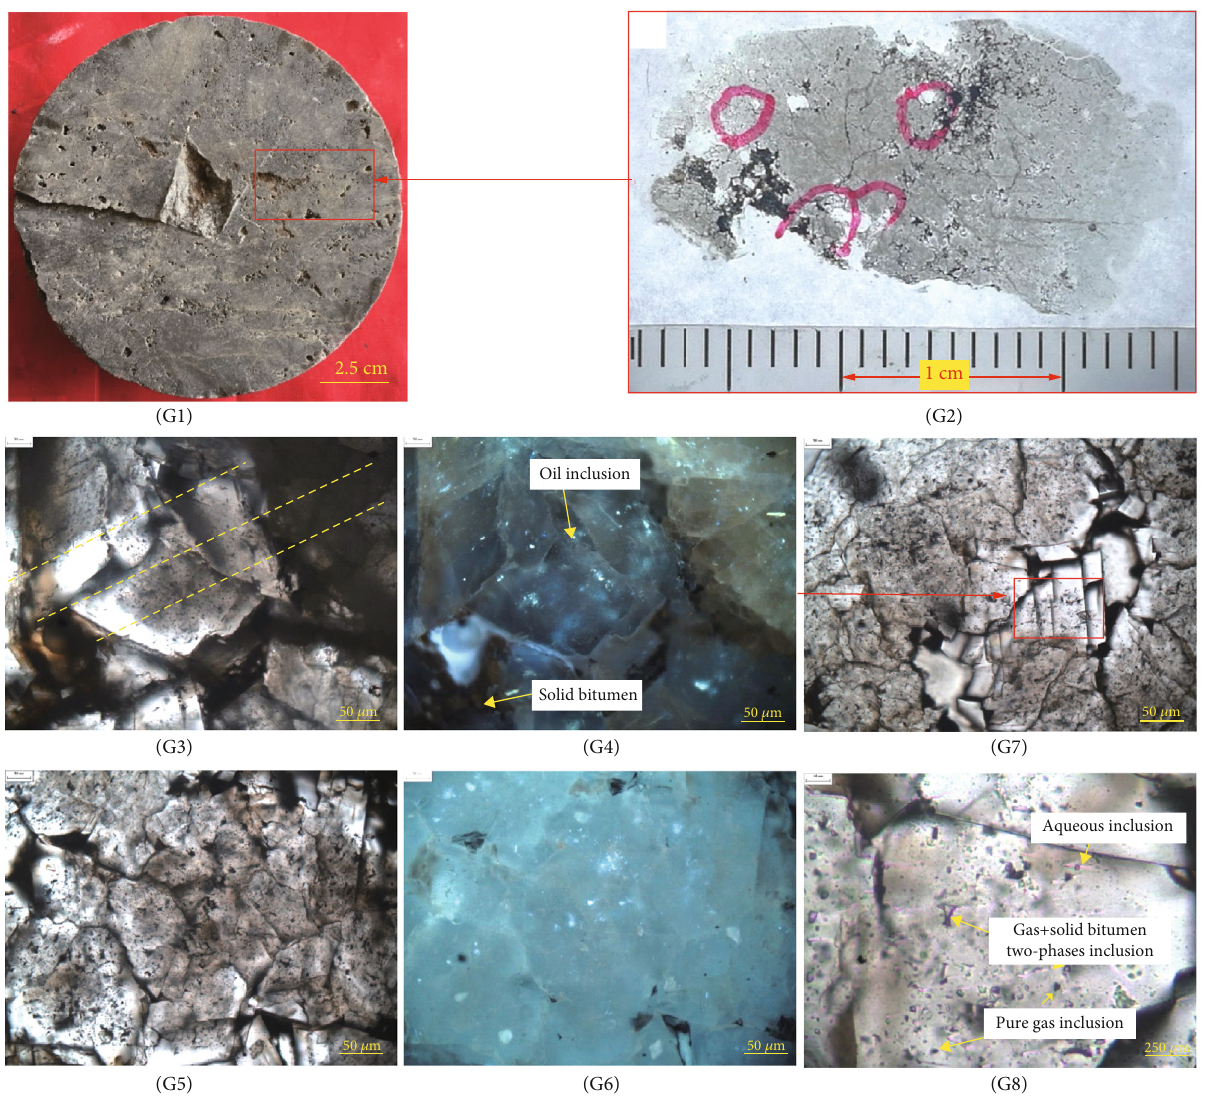
Figure 5: The Longwangmiao Formation Well MX20 (4605.34-4605.59 m). Fluid inclusion micrographs with petrologic and petrographic observations. (G1) Observed from the core, there are dissolution cavities in the massive granular fi ne powder crystal dolomite. (G2) Thin- slice scan shows that the dissolution cavities of granular dolomite are fi lled with solid asphalt. (G3) (-) Multigroup crack cutting dissolution hole edge fog-centered bright-edged dolomite. (G4) (UV) Crack captures bright blue+blue fl uorescent two-stage secondary oil inclusions, the main peak wavelength of the microscopic fl uorescence spectrum ( λ max ) is between 456 and 495 nm; intercrystalline pores/dissolution pores are fi lled with solid asphalt. (G5) Fog core bright edge fi ne powder crystal dolomite. (G6) (UV) Capture the blue primary oil inclusions in bright-edged dolomite, λ max = 455nm . (G7) (-) The pure gas-phase inclusions are captured in the cracks of the dolomite fi lled with dissolution pores. (G8) (-) Pure gas-phase inclusions and solid pitch+hydrocarbon gas two-phase inclusions. (-): single- polarized light; (UV): fl